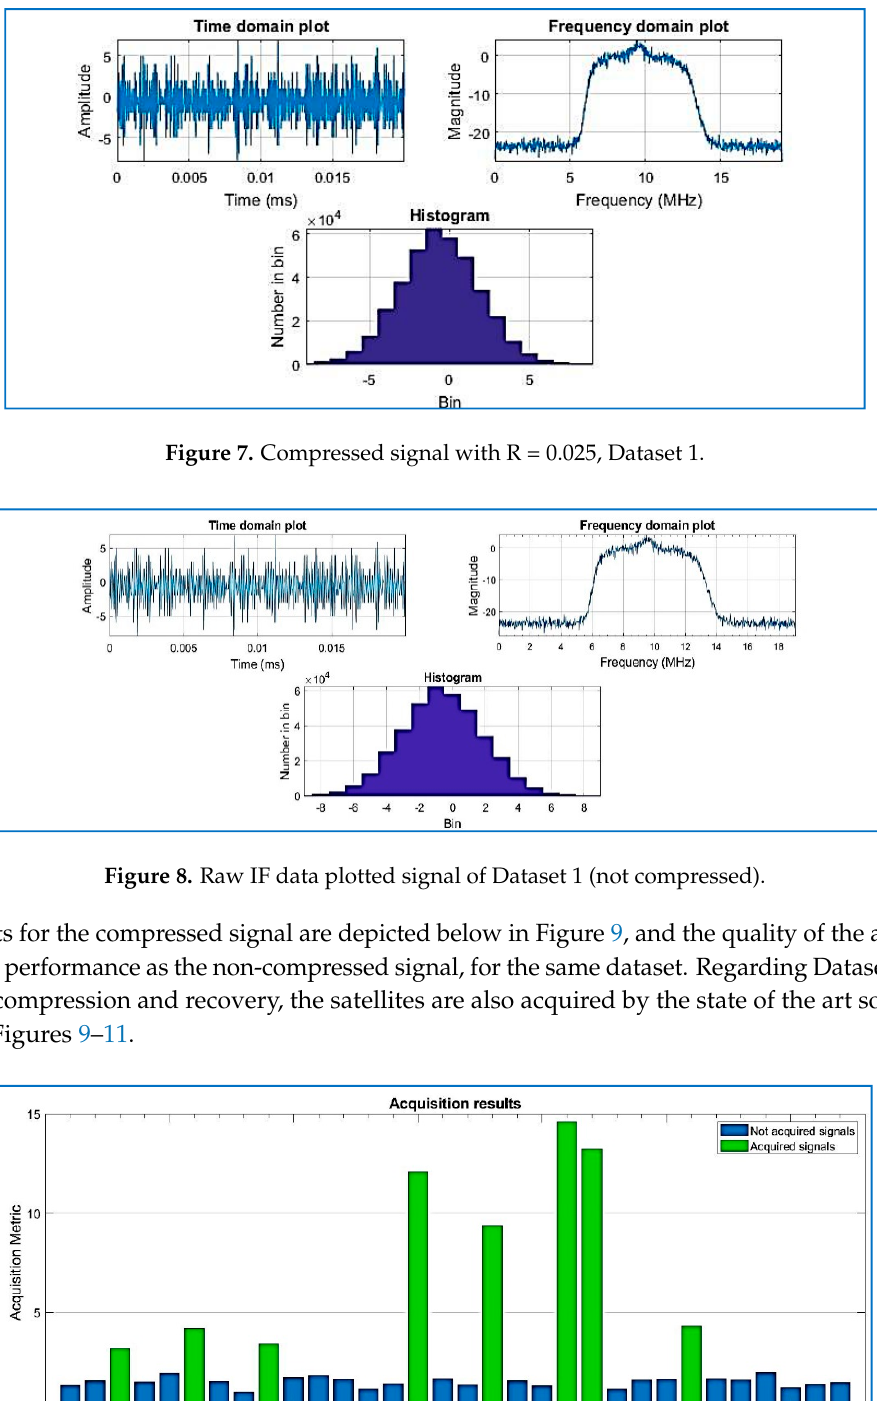
Figure 10. Acquired PRNs from Dataset 2. R = 0.03. Figure 11. Acquired PRNs from the RTLSDR receiver/Dataset 3. R = 0.30. Figure 12 shows the correlation outputs for a signal that was acquired using a regular method, which is a parallel code phase search, with a Doppler search step: 500 Hz and 2 ms data length (corresponding to 1 PRN) sampled at Fs = 38.192 MHz. The acquisition is successful when a satellite is visible, and one is provided with a coarse estimation of the carrier frequency of the GPS raw signal, as well as its code phase. In theory, only one dominant peak should be observed at the correct